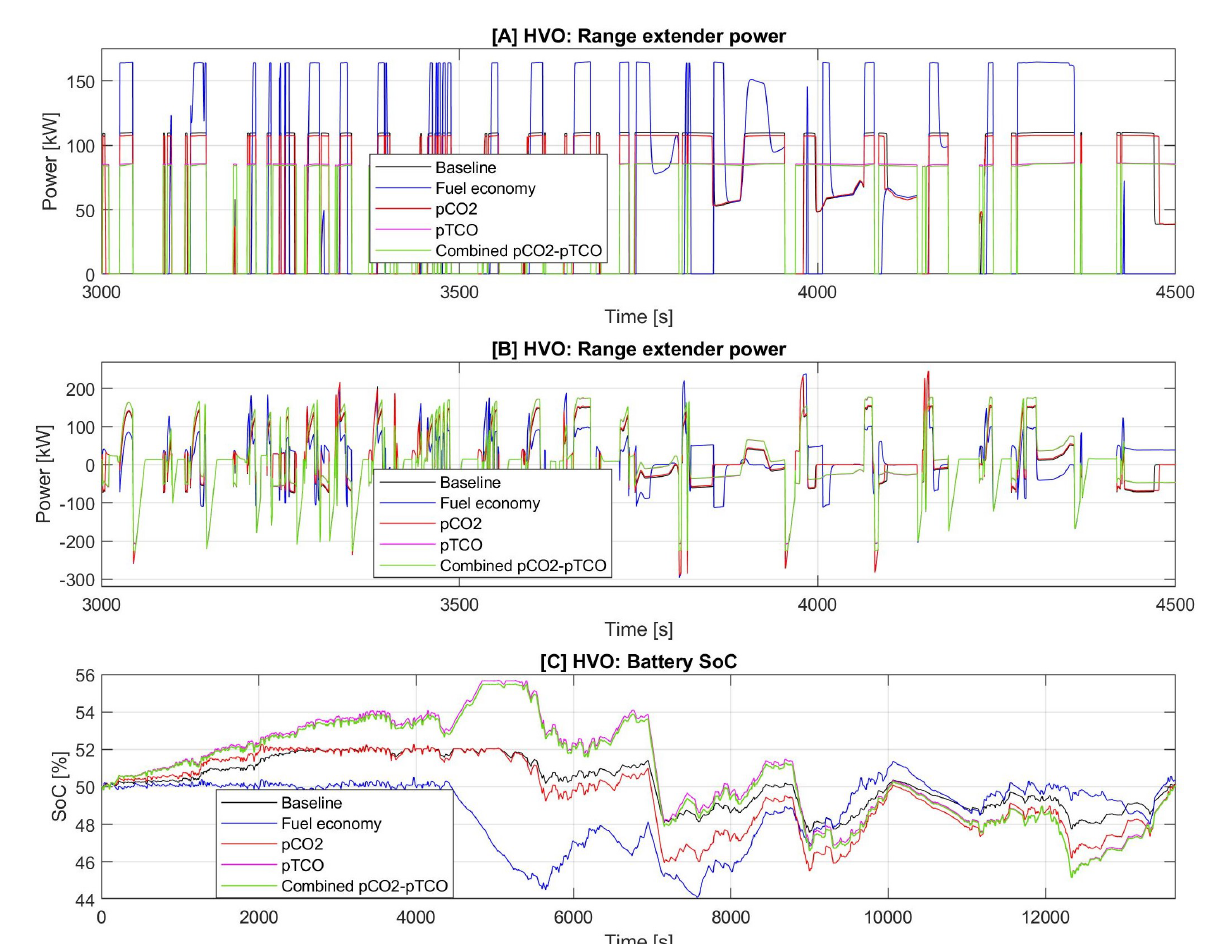
Figure 12. Comparison of ( A ) range extender power output, ( B ) battery power draw and ( C ) SoC variation for various HVO-fueled sizing solutions. Range extender, battery and eDrive size varied for different solutions as seen in Figure